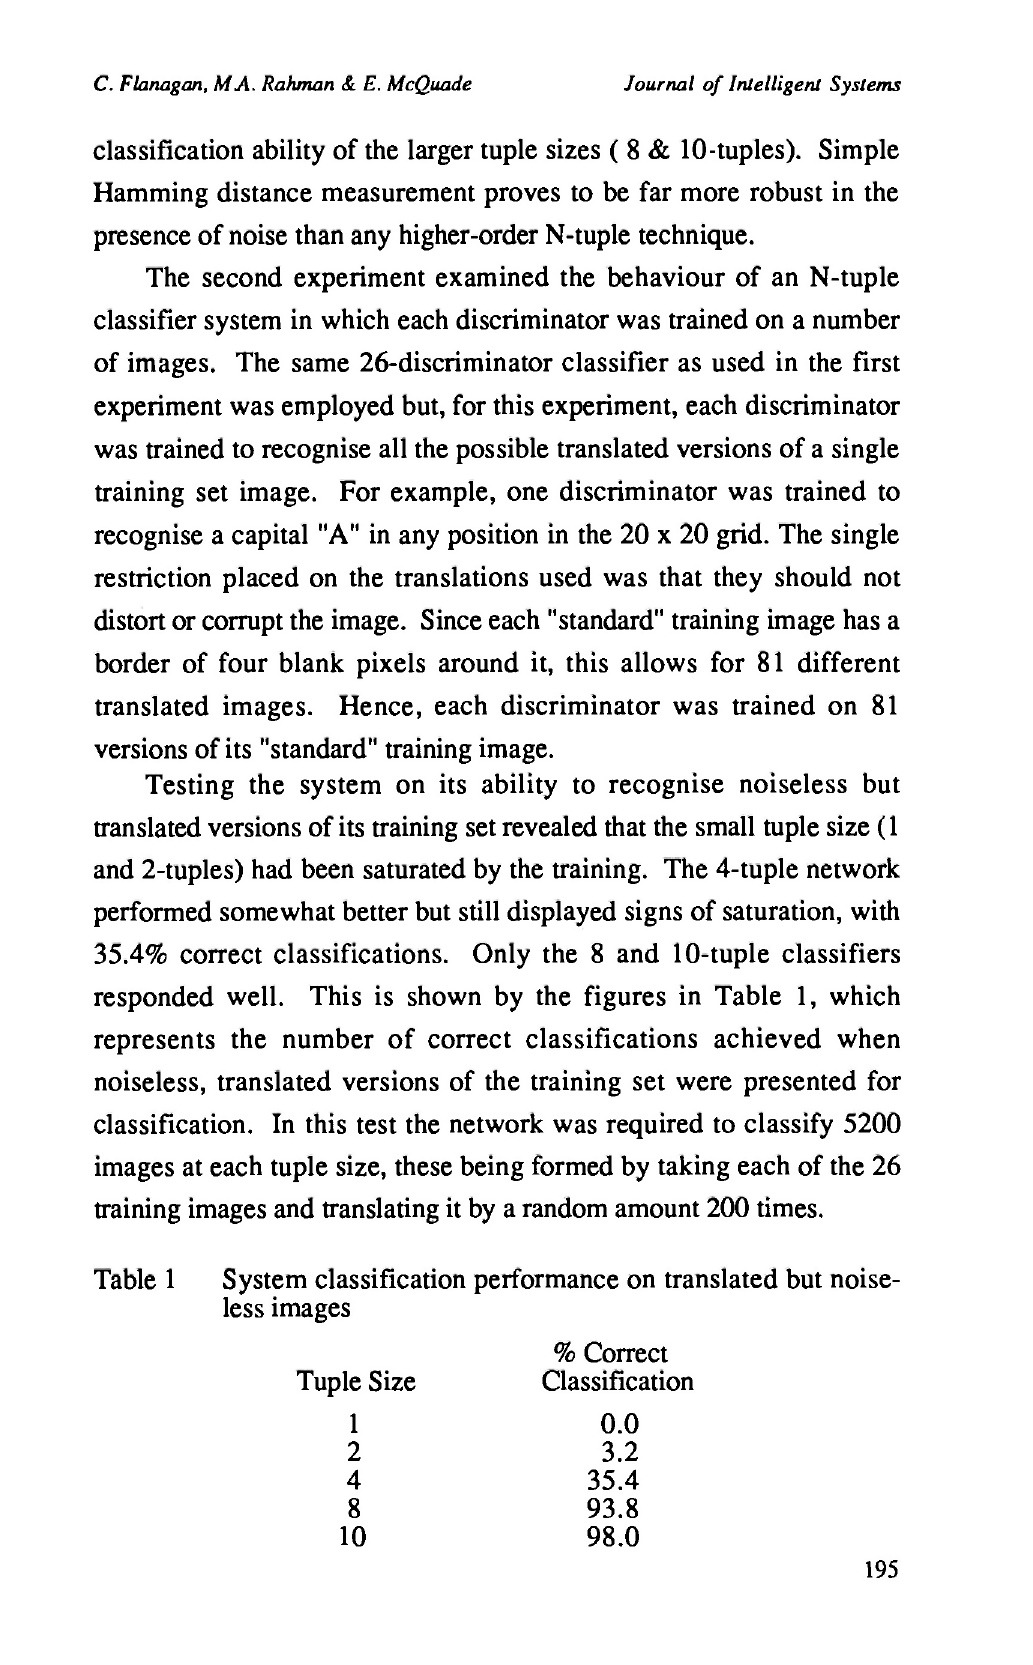
System classification performance on translated but